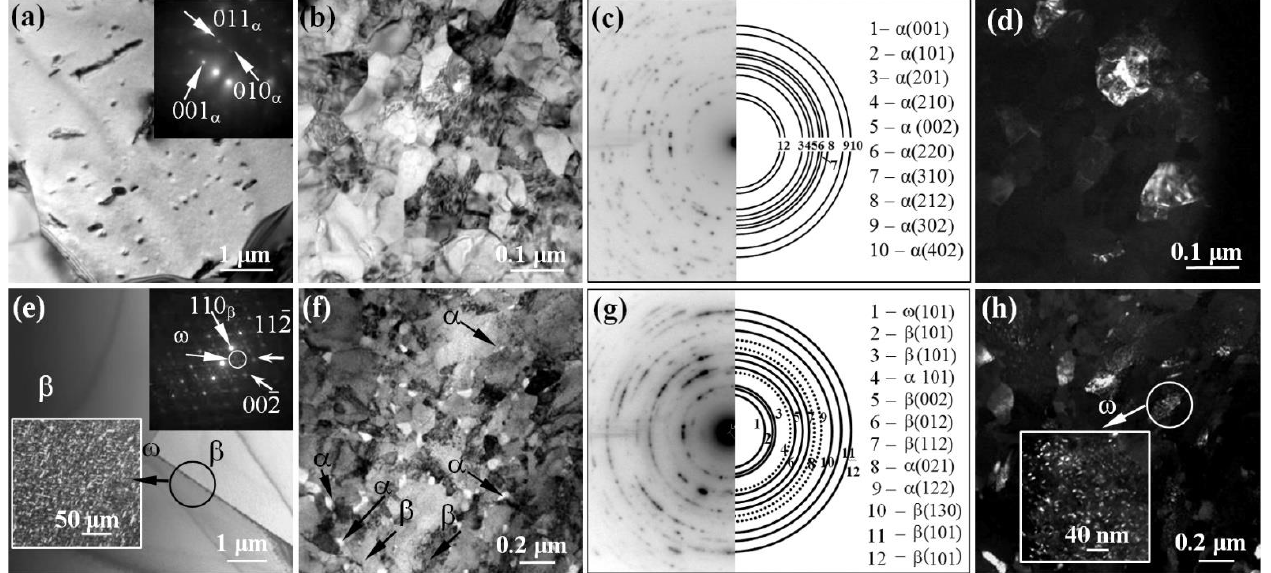
Figure 1. Microstructure of the pure titanium ( a – d ) and Ti-45Nb alloy ( e – h ) in the CG ( a , e ) and UFG states ( b – d , f – h ): ( a , b , e , f ) — the BF TEM images with corresponding SAD patterns; ( d , h ) — the DF TEM images. The arrows show the reflections from the identified phases and the phases themselves.